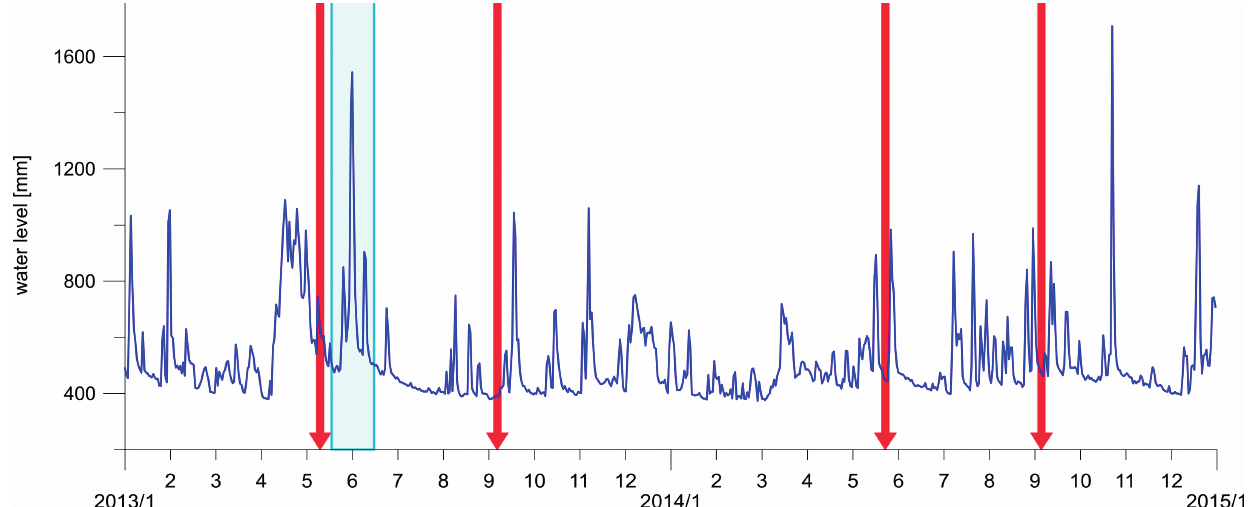
Figure 5. Dynamics of hydrological regime of Roklanský brook. Daily average water levels in the period 2013–2014 with highlighted terms of UAV imaging (red arrows) and period of flood event in June 2013 (light blue box). Data: Charles University in